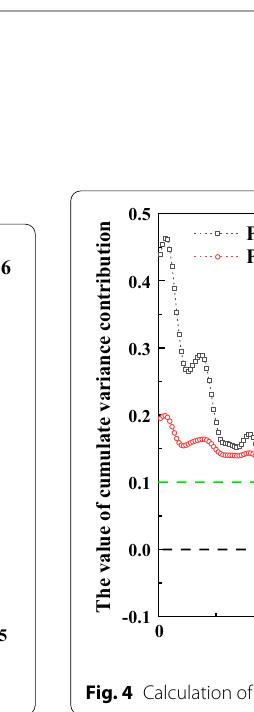
Fig. 2 The characteristic variable selection results of SPA, a is the variable selection without pretreatment; b is the variable selection with baseline correction; c is the variable selection with MSC; and d is the variable selection with normalization